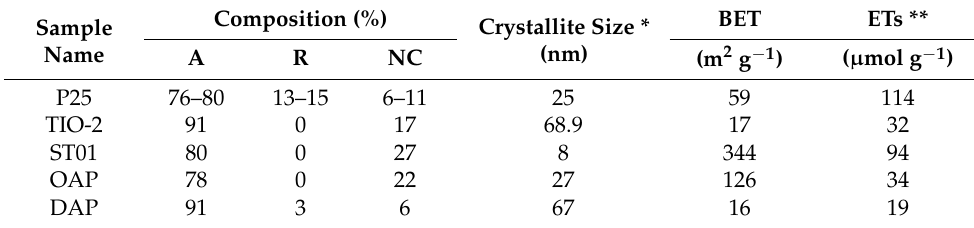
Table 4. The properties of titania (pristine) samples.